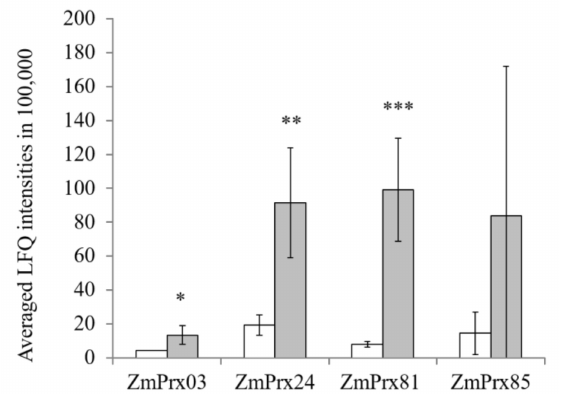
Figure 3. Mass spectrometry analyses of the plasma membrane for class III peroxidases in control and hypoxia-stressed maize roots. Plasma membranes of controls (white columns) and 24 h hypoxia-stressed maize roots (gray columns) were used for mass spectrometry analyses. Label-free quantifications (LFQ) data were determined with MaxQuant software and used for further statistical analyses. Error bars indicate standard deviation. Asterisks indicate significances ( p < 0.05 *, p < 0.01 **, and p < 0.001 ***) determined with Student’s t -test for three biological and two technical replicates per